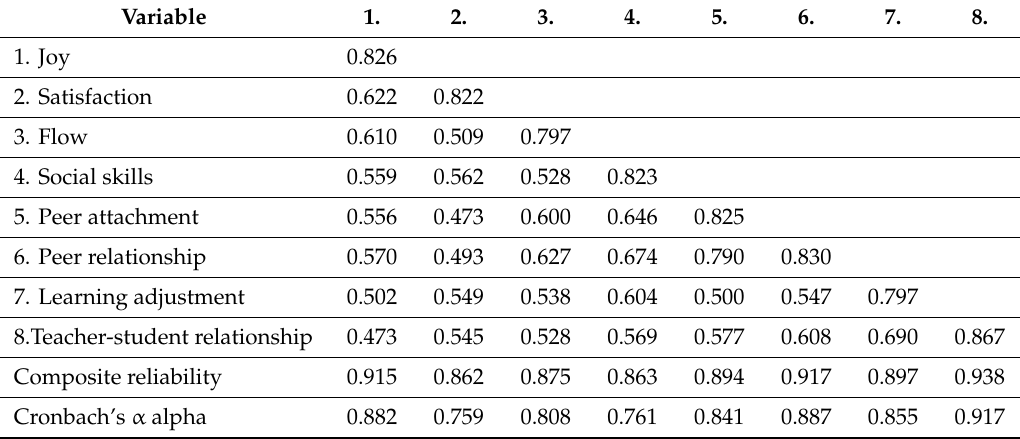
Table 1. Reliability analysis and latent variable